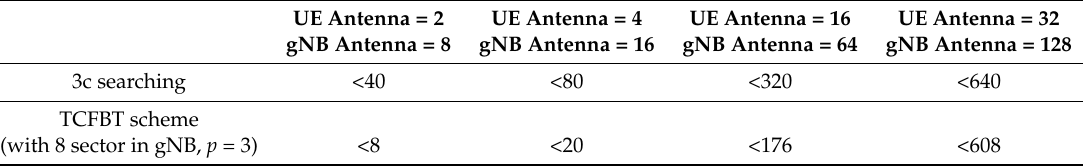
Table 2. The complexity of beam pair